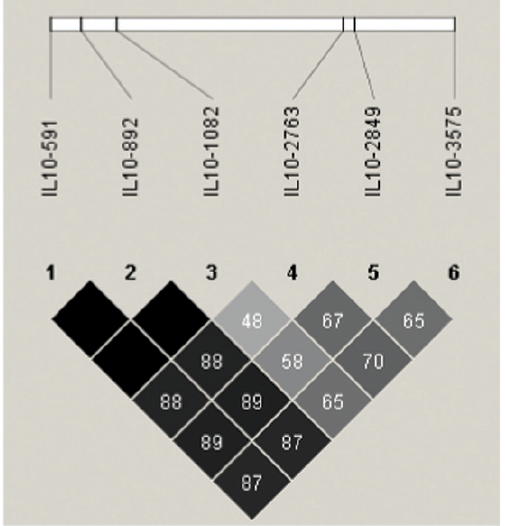
Figure 1 - Linkage disequilibrium (LD) map of the IL10 SNPs rs1800872, 1800896, 6693899, 3703630 and 1800890. An LD map based on the controls was drawn using Haploview version 4.1. Triangular heat map display of the LD index. Pairs of the IL10 SNP alleles in strong LD (D 9. 0.75) are highlighted in gray or